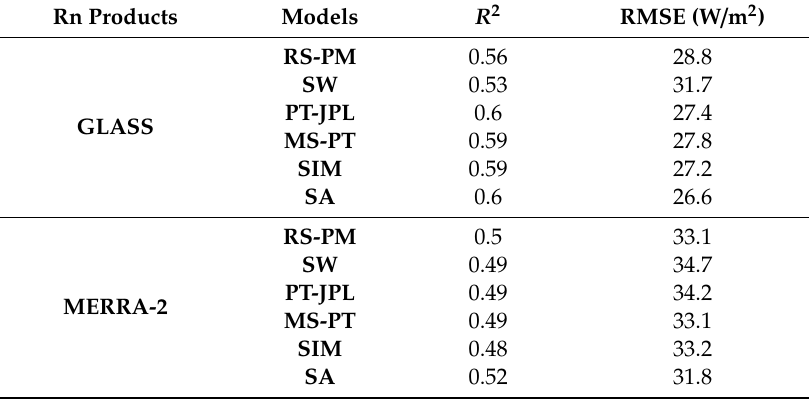
Table 1. Table of statistics (RMSE and R 2 ) of the comparison between LE estimation from multiple